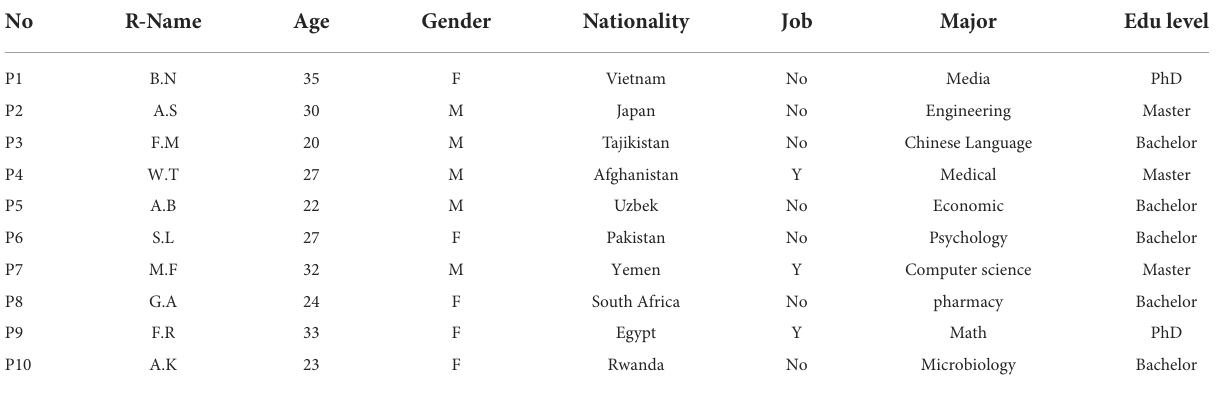
TABLE 1 Demographic information of the interviewed